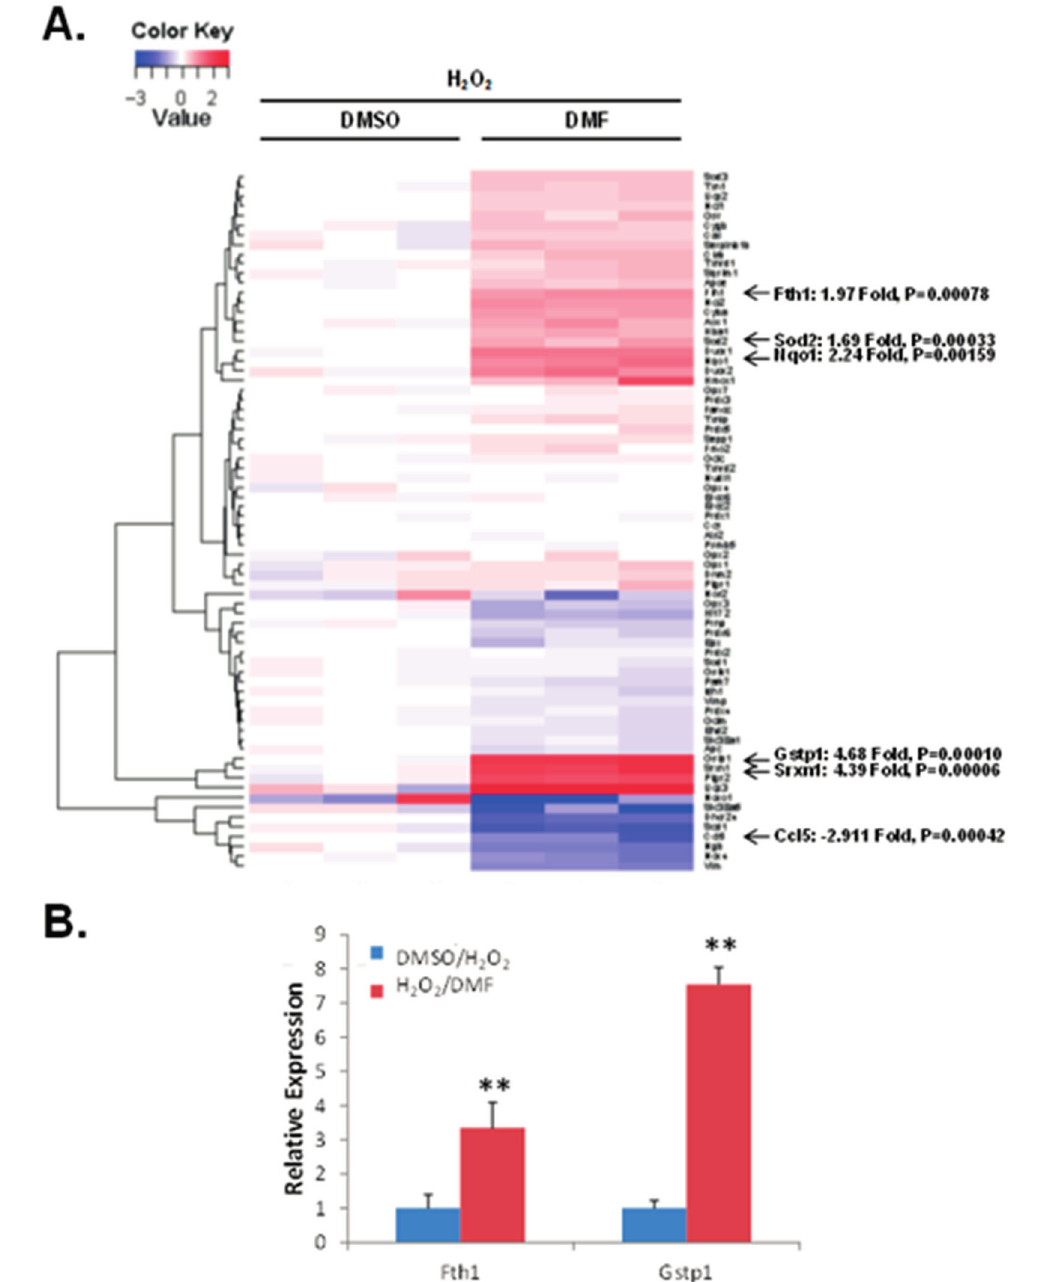
Figure 6. Identification of additional anti-oxidative stress genes by SuperArray gene screening technology. ( A ) SuperArray gene screen technology for anti-oxidative stress genes was performed as described under “Material and methods”. DMF significantly up-regulates gene expression of Gstp1 , Nqo1 , Sod2 , Srxn1 , and Fth1 , with down-regulation of Ccl5 ; ( B ) Confirmation Real-Time qRT-PCR. Up-regulation of Gstp1 and Fth1 genes were further confirmed by Real-Time qRT-PCR. Mean ± SEM were determined from 3 replicate samples. ** p =